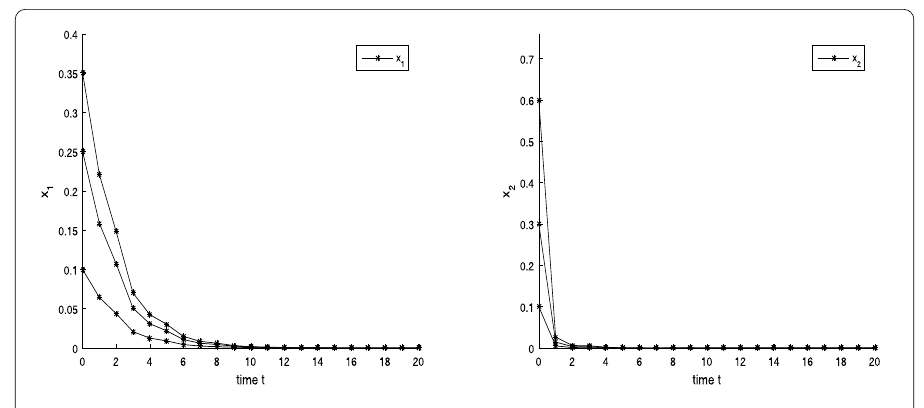
Figure 2 Dynamic behaviors of system (6.2) with initial condition ( x